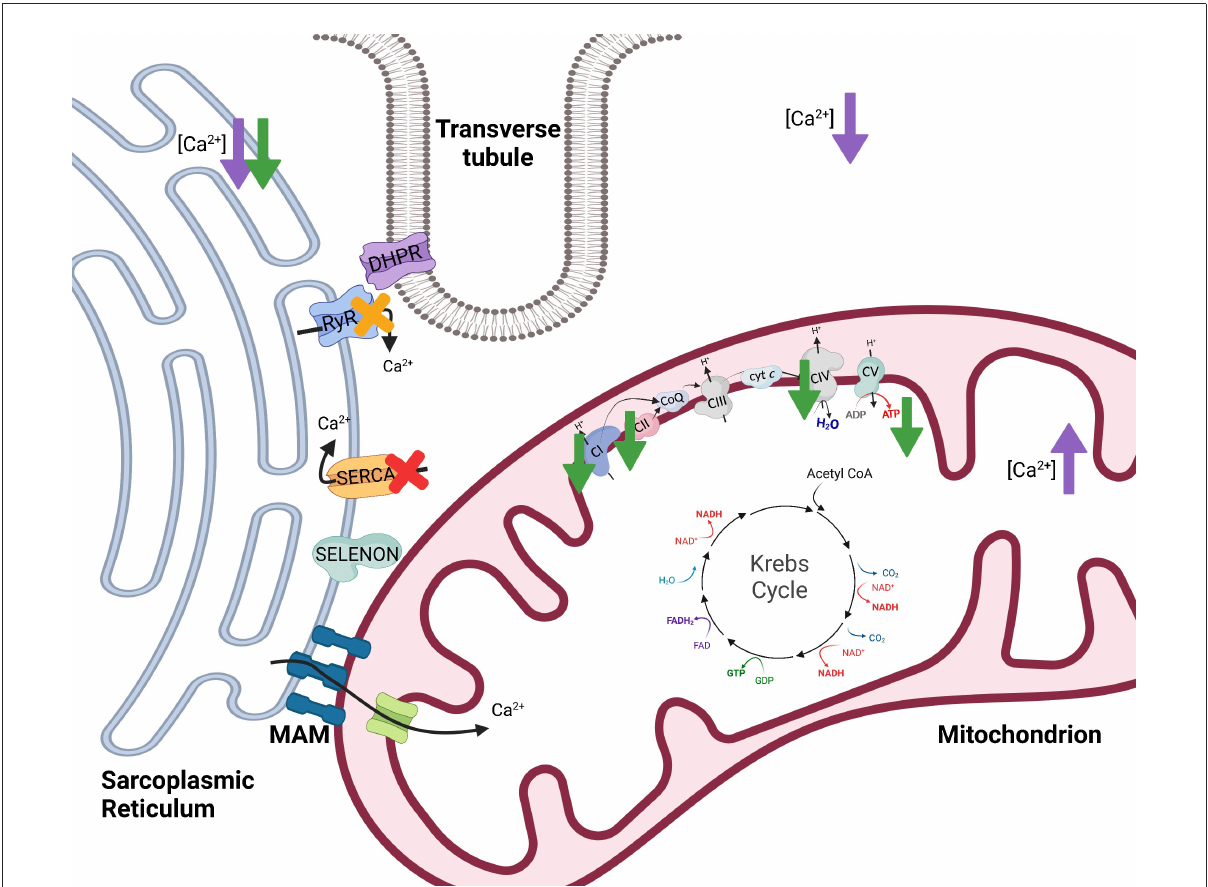
FIGURE4 The effects of selenoprotein N1 (SELENON) and selenoprotein W (SELENOW) knockout/deficiency in skeletal muscle. To initiate muscle contraction, an action potential travels down the Transverse tubule (T-tubule) to activate voltage-gated channels known as dihydropyridine receptors (DHPR) triggering the ryanodine receptor (RyR) to release Ca 2 + . When stimulated with 100mM caffeine, myofibers from SELENON deficient mice had reduced amplitude of Ca 2 + release which suggests that RyR of the sarcoplasmic reticulum may be impaired with loss of SELENON [yellow X (45)]. Further, SELENON serves to regulate calcium and redox homeostasis by interaction with and activation of the sarco/endoplasmic reticulum calcium transport ATPase (SERCA) 2b [red X (46)]. Cells deficient in SELENON had lower ER Ca 2 + , less Ca 2 + transport into the mitochondria, reduced ATP content, reduced complex I (CI) activity, and impaired function of complexes II (CII) and IV (CIV) of the electron transfer system [green arrows (43)]. Lastly, SELENOW deficiency in myoblasts resulted in decreased Ca 2 + in the cytoplasm and sarcoplasmic reticulum but increased Ca 2 + levels in mitochondria [purple arrows (47)]. Created with